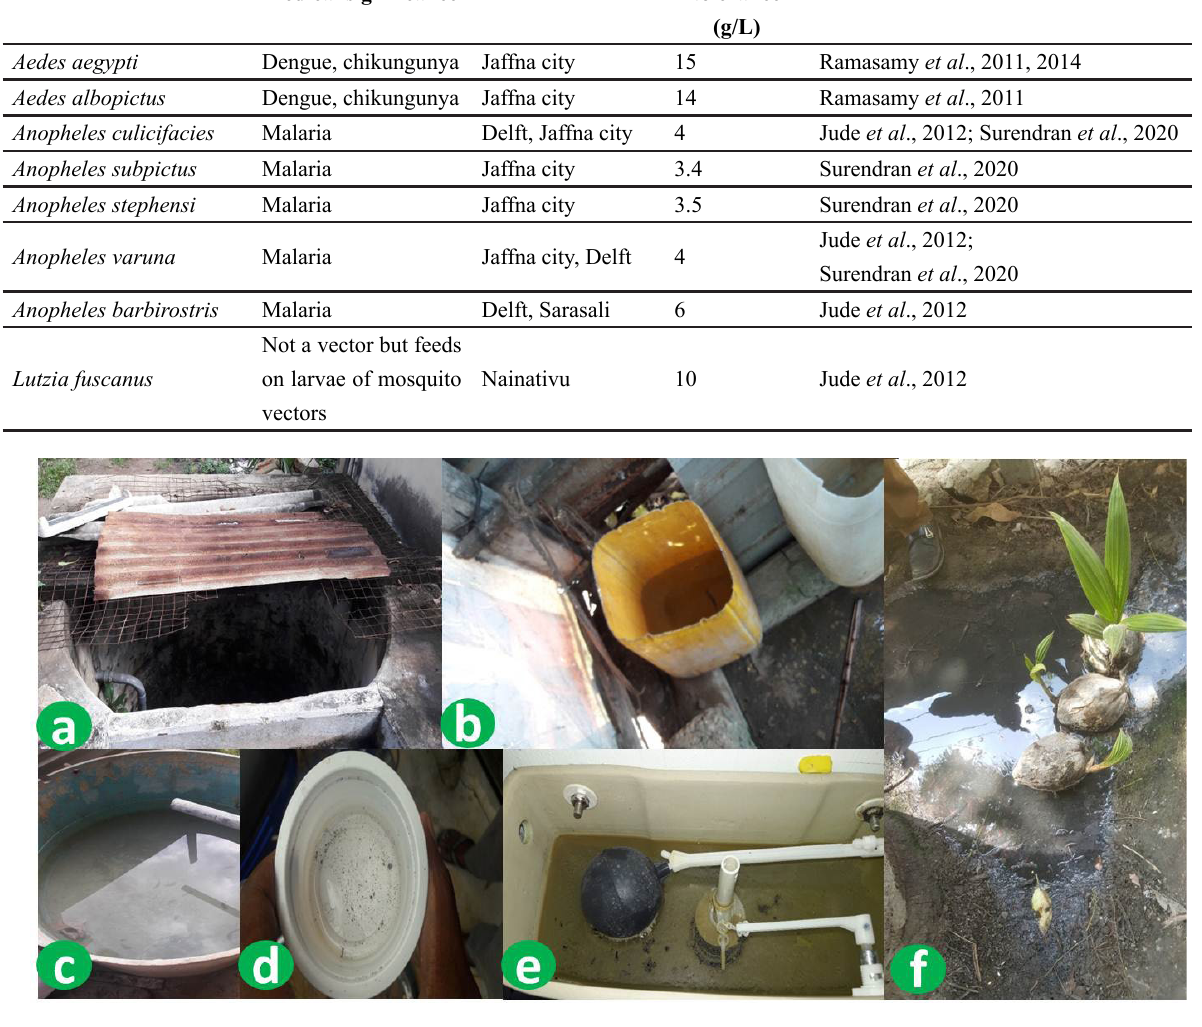
Figure 4: Brackish water habitats for preimaginal development of mosquito vectors in the Jaffna peninsula.- a. Domestic well with 5 g/L (ppt) salt brackish water, b. Plastic bucket with 2 g/L (ppt) salt brackish water, c. Water tank with 2 g/L (ppt) salt brackish water, d. Plastic container with 3 g/L (ppt salt brackish water, e. A puddle in a domestic area with 2 g/L (ppt) salt brackish water and f. Open water flush with 3 g/L (ppt) salt brackish